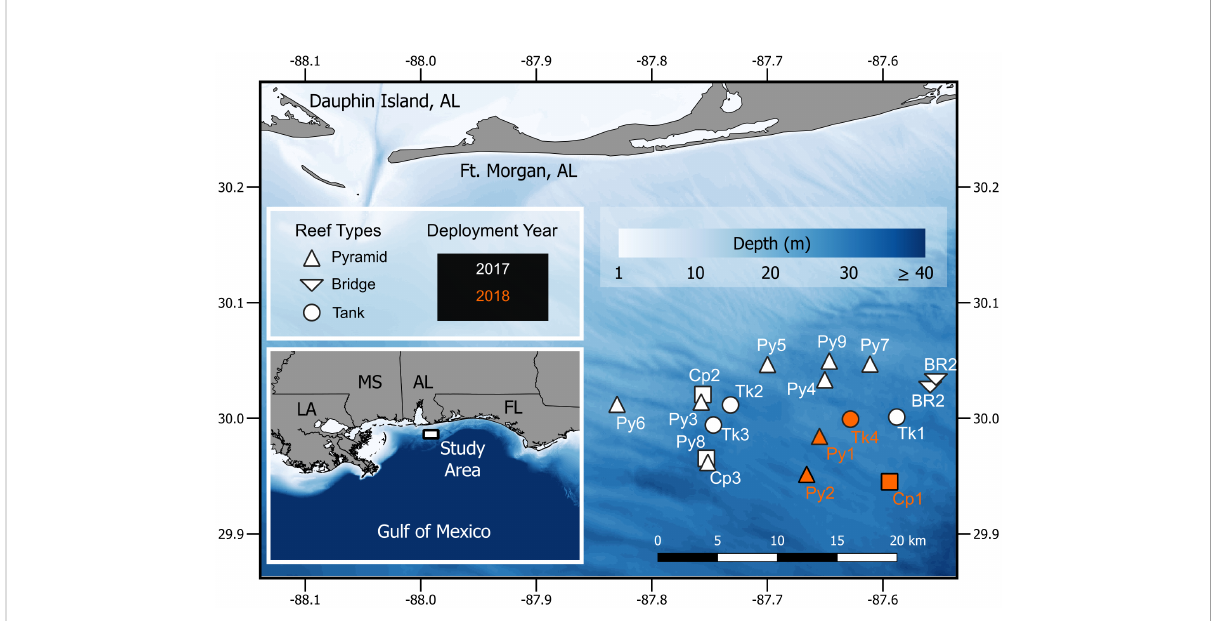
FIGURE 1 Alabama arti fi cial reef sites where passive acoustic monitoring devices were deployed in 2017 (white) and 2018